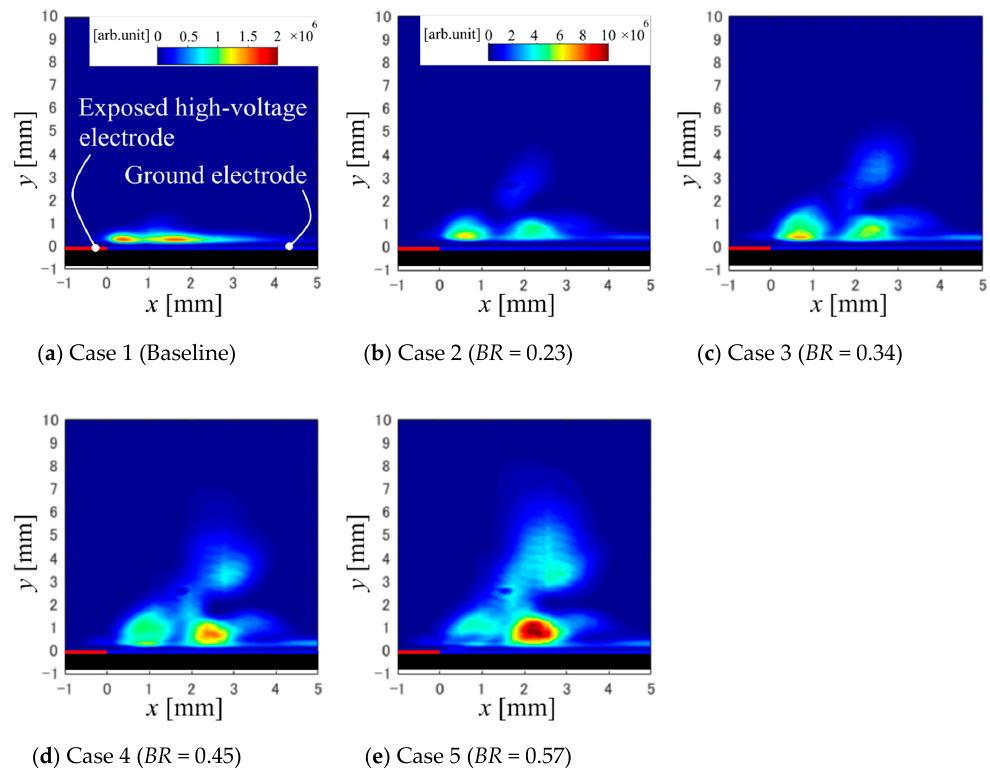
Figure 11. Power spectrum density distribution at 200 Hz. The contour level is the same in all figures expect for Case 1.